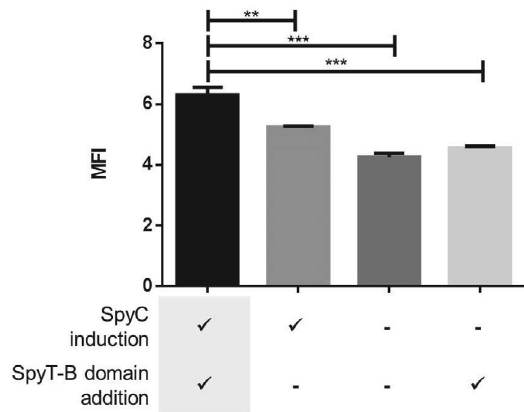
Fig. 3. Flow cytometric analysis of binding of SpyTag (SpyT)-B do- main, isolated from E. coli, to L. lactis cells displaying SpyCatcher (SpyC) on their surface. FITC-conjugated human IgG was used for detection. Mean fluorescence intensity (MFI) value of SpyC-dis- playing bacteria with added SpyT-B domain was compared to those of the controls by using Student’s t test. ** p<0.01, *** p<0.001.